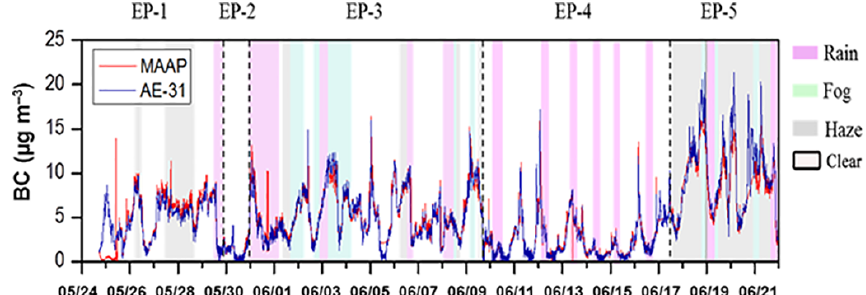
Figure 7. BC concentrations converted from the data measured by the AE-31 and MAAP. Good correlation is